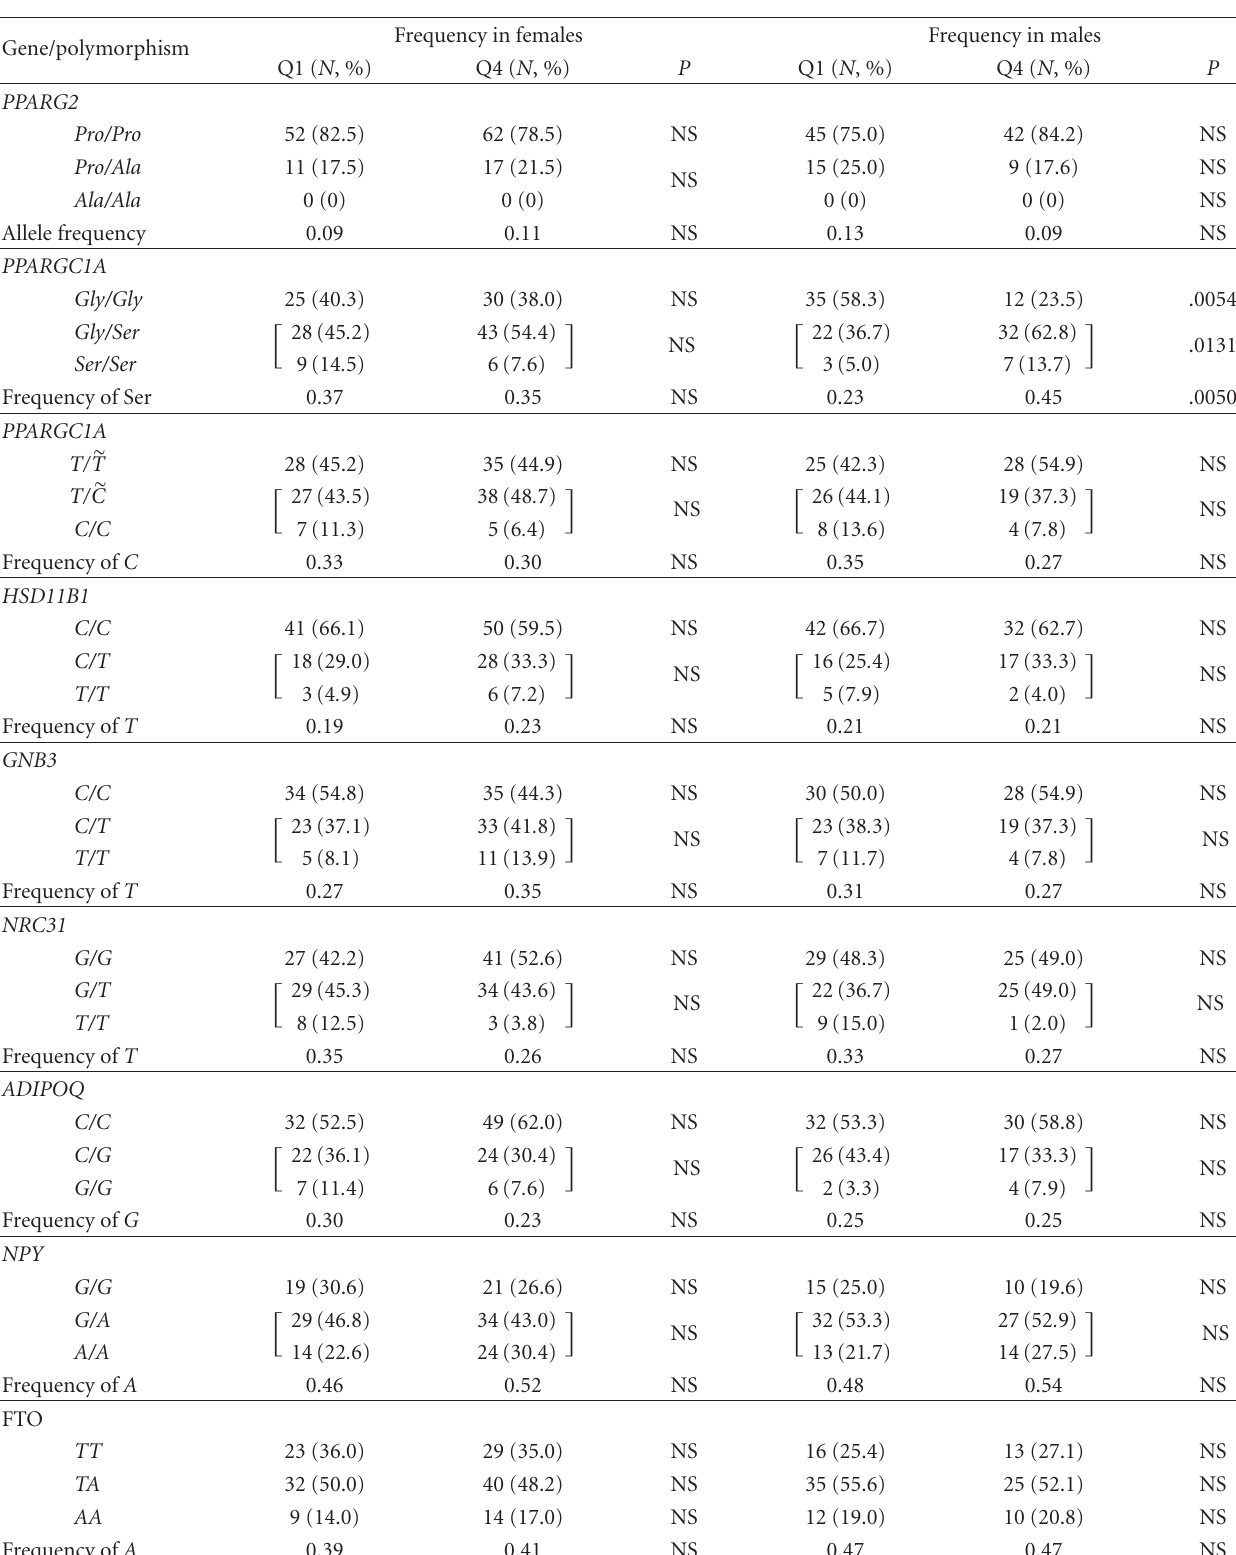
Table 2: Genotype and allele frequencies of the variants in candidate genes examined for association with weight gain by DCCT subjects on intensive diabetes therapy. N , number of subjects; the P -values compare genotype and minor allele frequencies between quartile 1 (Q1) and quartile 4 (Q4) of weight gain; NS, statistically not significant. The brackets indicate that heterozygotes and homozygotes for the minor allele were combined for comparisons between